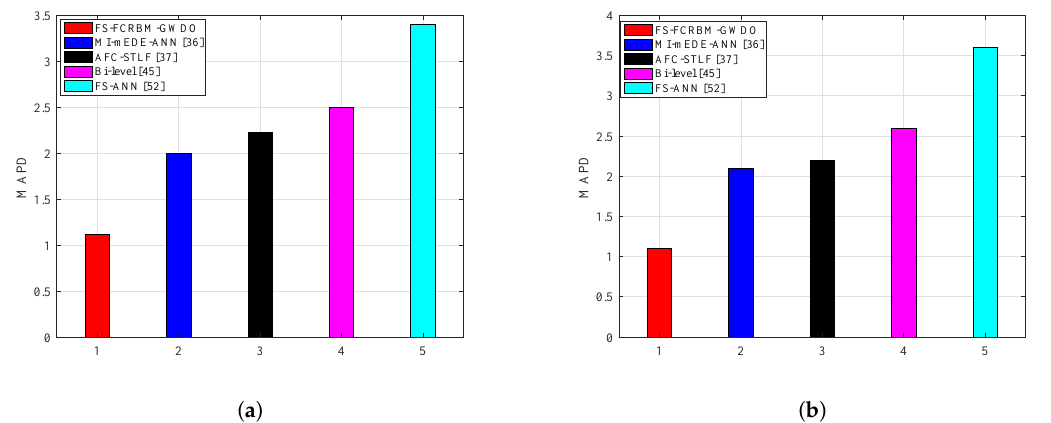
Figure 11. Accuracy analysis of the proposed hybrid FS-FCRBM-GWDO model and benchmark models in terms of MPAD on FE power grid hourly load data. ( a ) Day ahead; ( b ) Week ahead.